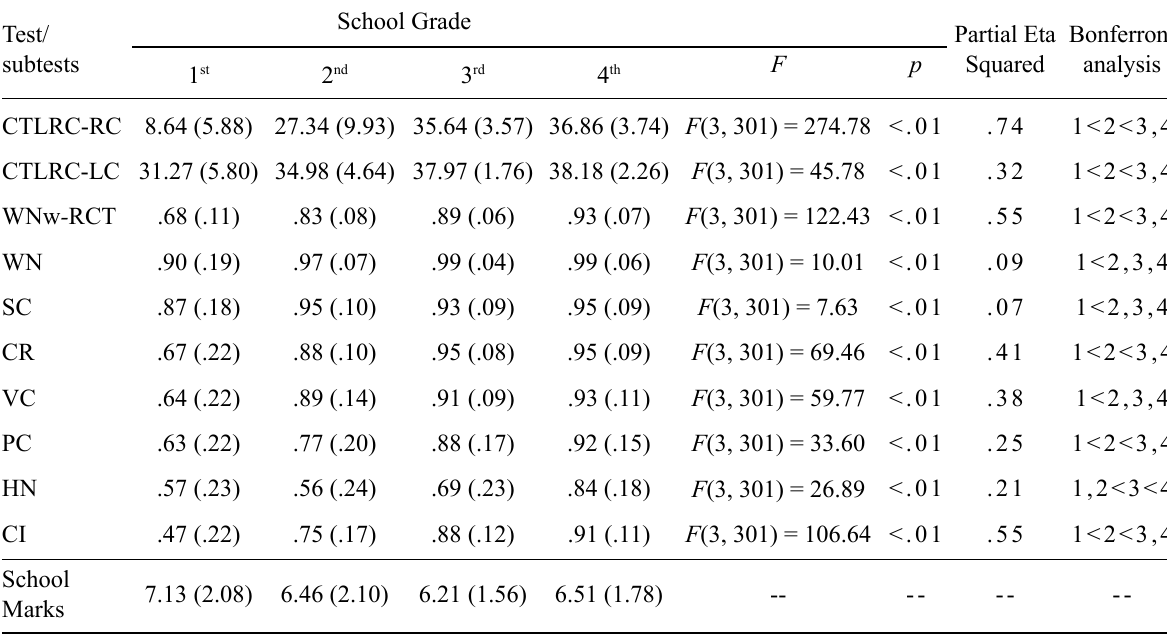
Descriptive and Inferential Statistics Obtained After MANOVAs of the Effect of Grade Levels on the Performances on CTLRC, WNw-RCT, and School Marks Average (Standard Deviation in Parentheses), as a Function of School Grade